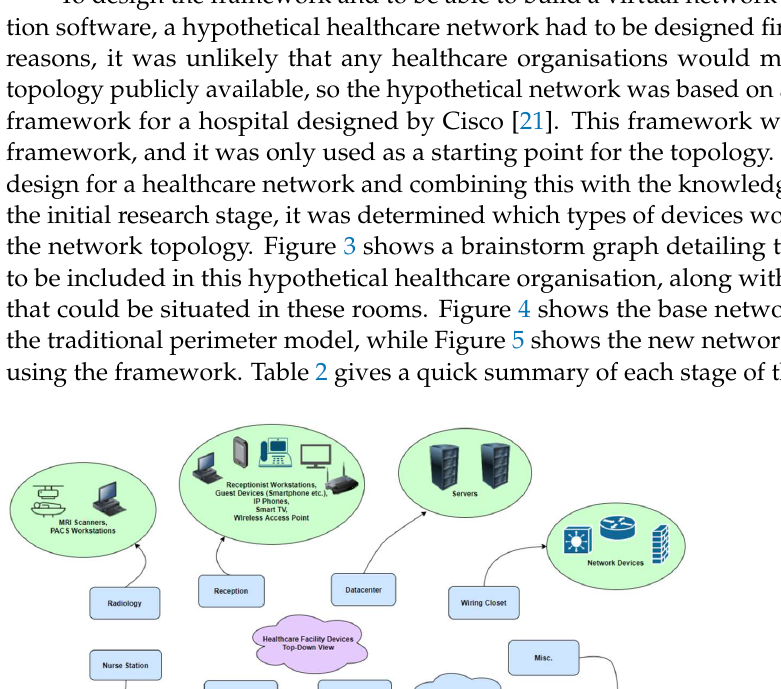
Figure 4. Base network topology for a hypothetical healthcare organisation. Figure 5. Summary of the framework to support healthcare organisations in transitioning to a zero- trust-inspired network architecture with an example network topology.